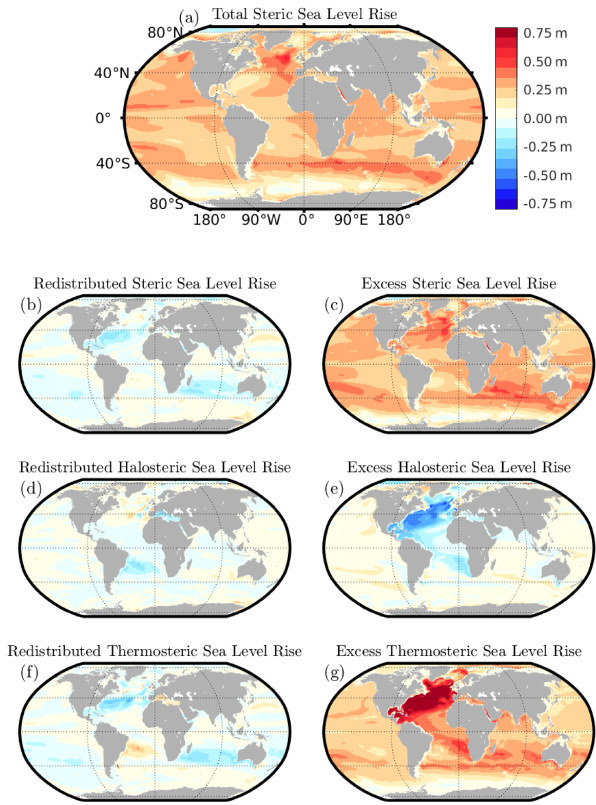
Figure 10. 2090s mean steric, halosteric, and thermosteric contri- butions to sea level rise, as well as the total, from the upper 2000m of the